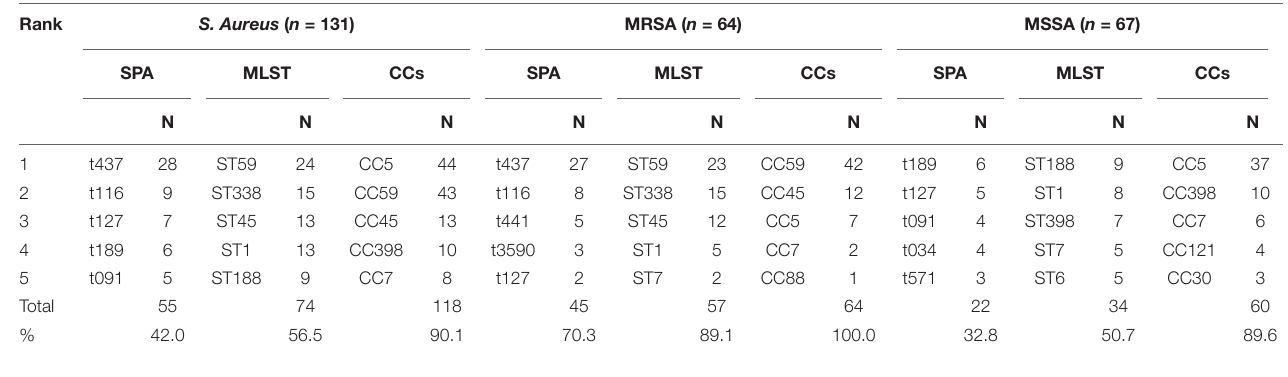
TABLE 2 | Genotype ranking of S. aureus isolated from women and children in Guangzhou,